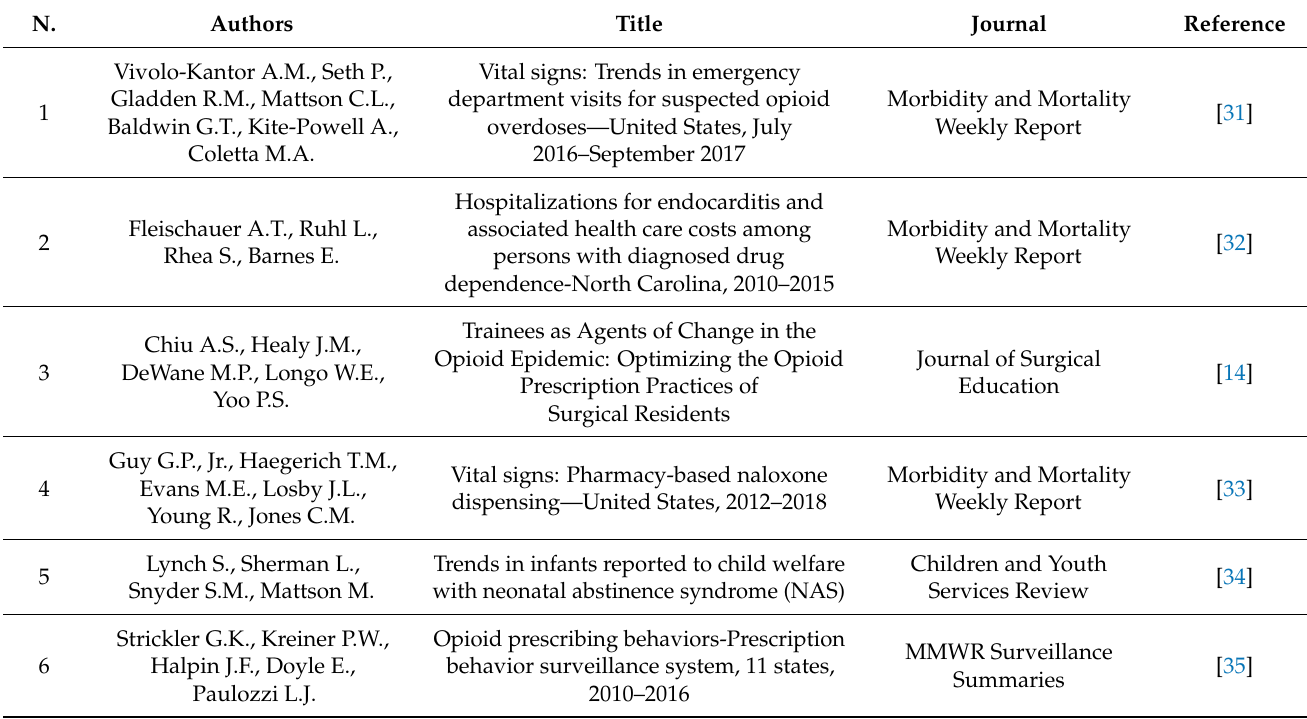
Table 1. Papers included in the